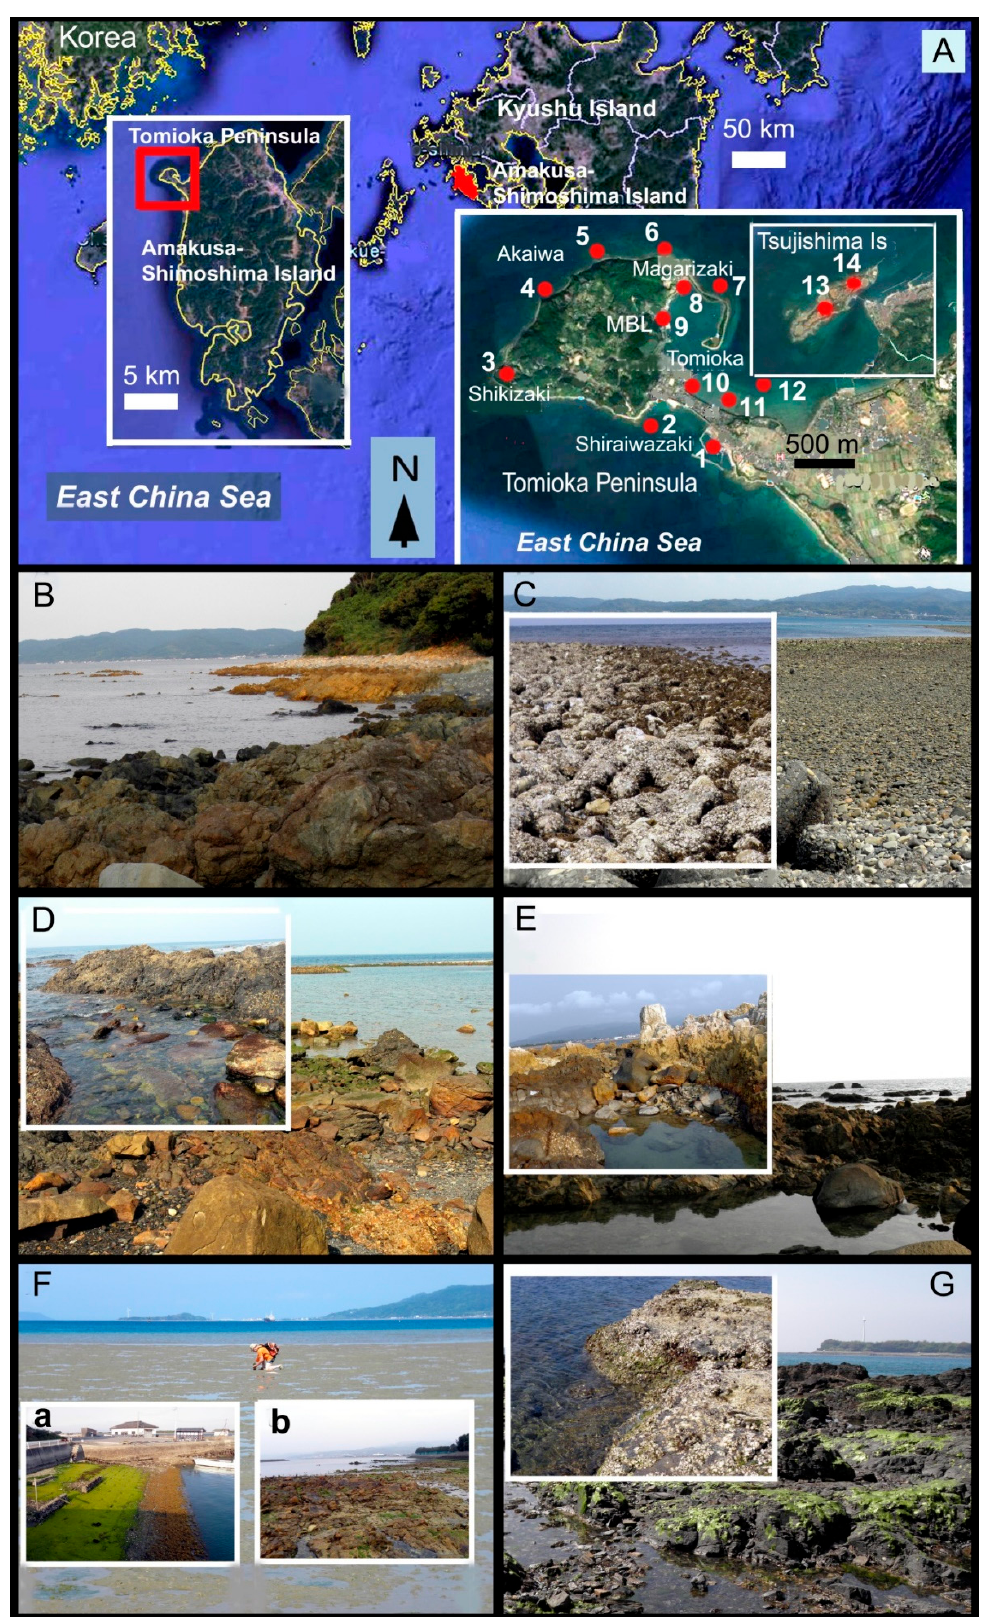
Figure 1. Algal sampling sites in the Tomioka Peninsula, Amakusa-Shimoshima Island, in 2012–2017. ( A ) Sampling location and sampling points (red circles); ( B ) Akaiwa, sampling point 5; ( C ) Magarizaki, sampling point 7; ( D ) Shikizaki Bay, sampling point 3; ( E ) Shiraiwazaki Bay, sampling point 2; ( F ) Tomioka Harbor, (a) sampling point 9, (b) sampling point 11; ( G ) Tsujishima Islet, sampling point 14.